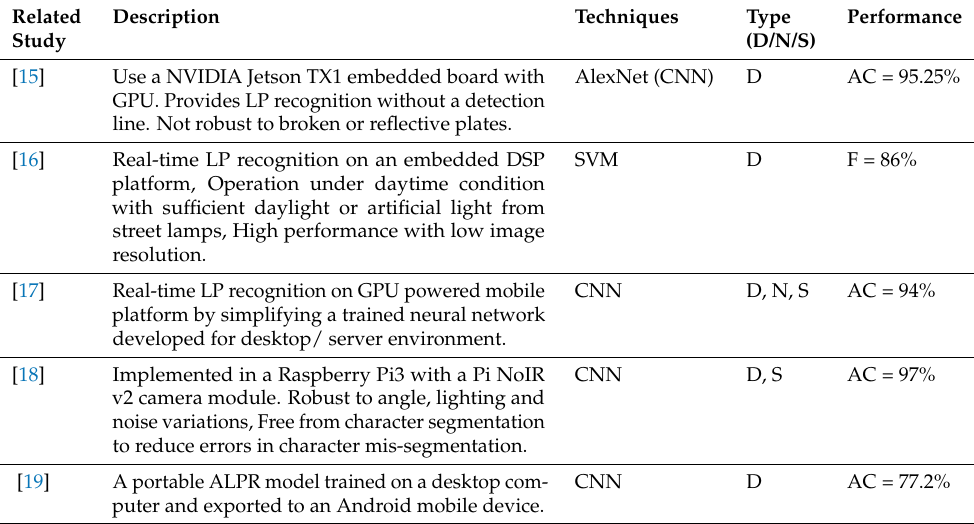
Table 1. Summary of the related LP recognition studies on edge platforms.